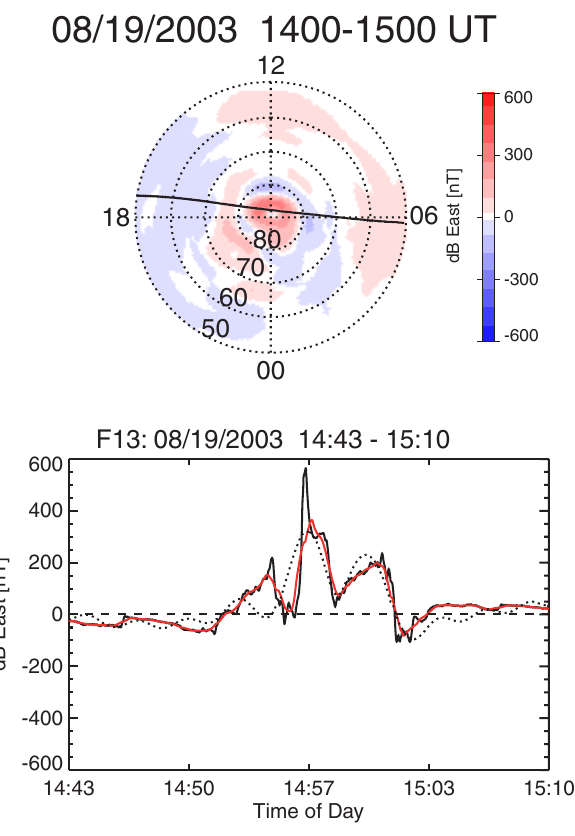
Fig. 12. Comparison of the fitted magnetic perturbations from Irid- ium (dotted line) with DMSP F13 observation (solid black line) dur- ing the interval 19 August 2003, 14:00–15:00UT. The red solid line shows the 50s boxcar average of the DMSP F13 data.